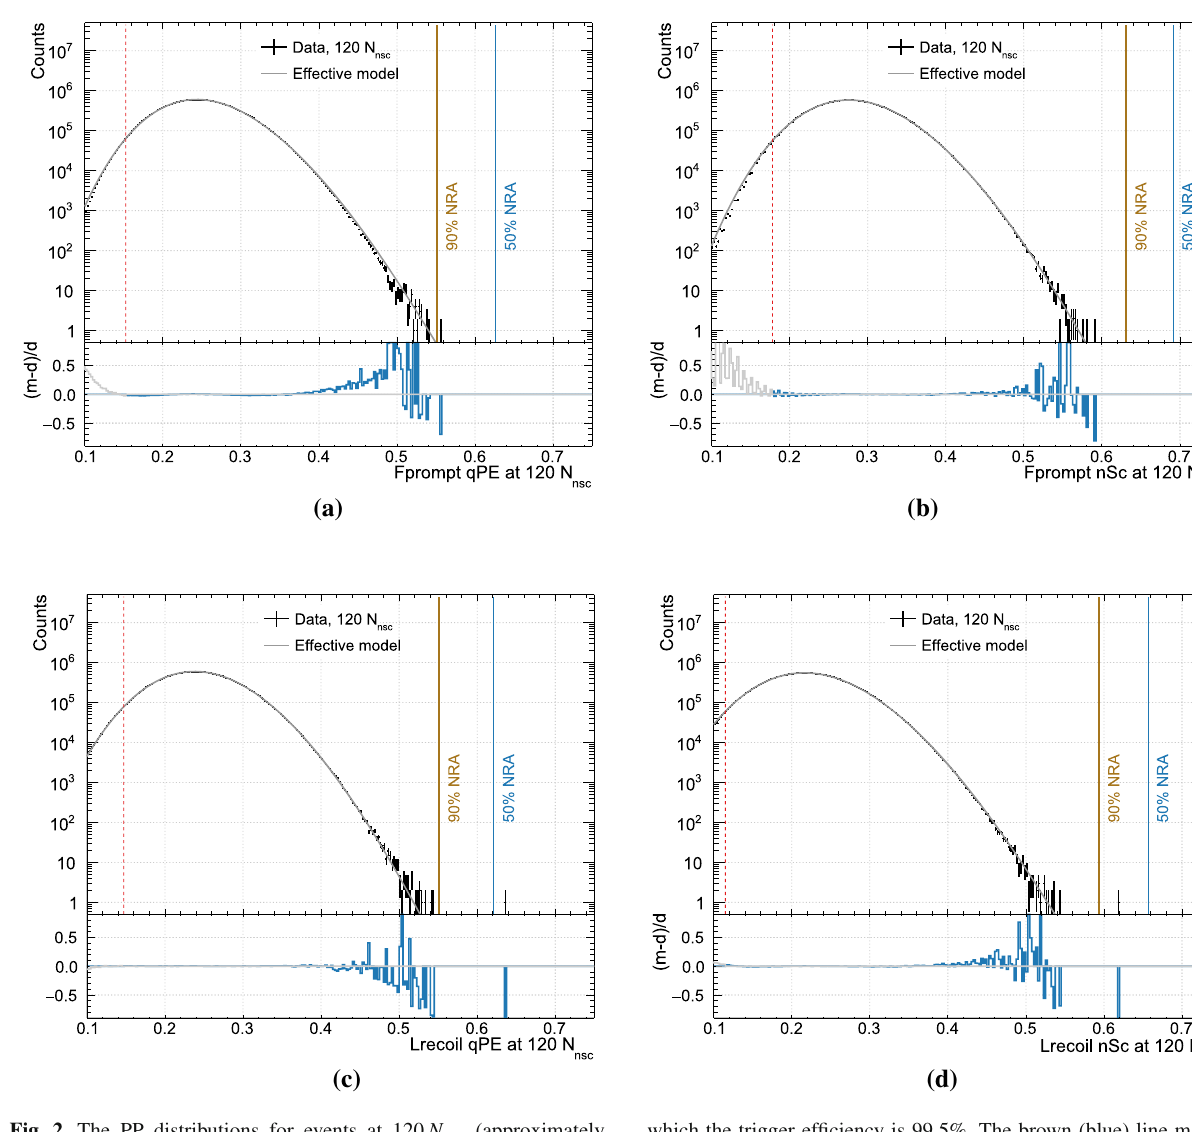
which the trigger efficiency is 99.5%. The brown (blue) line marks a nuclear recoil acceptance of 90% (50%). The lower panel shows the relative deviation between the model and the